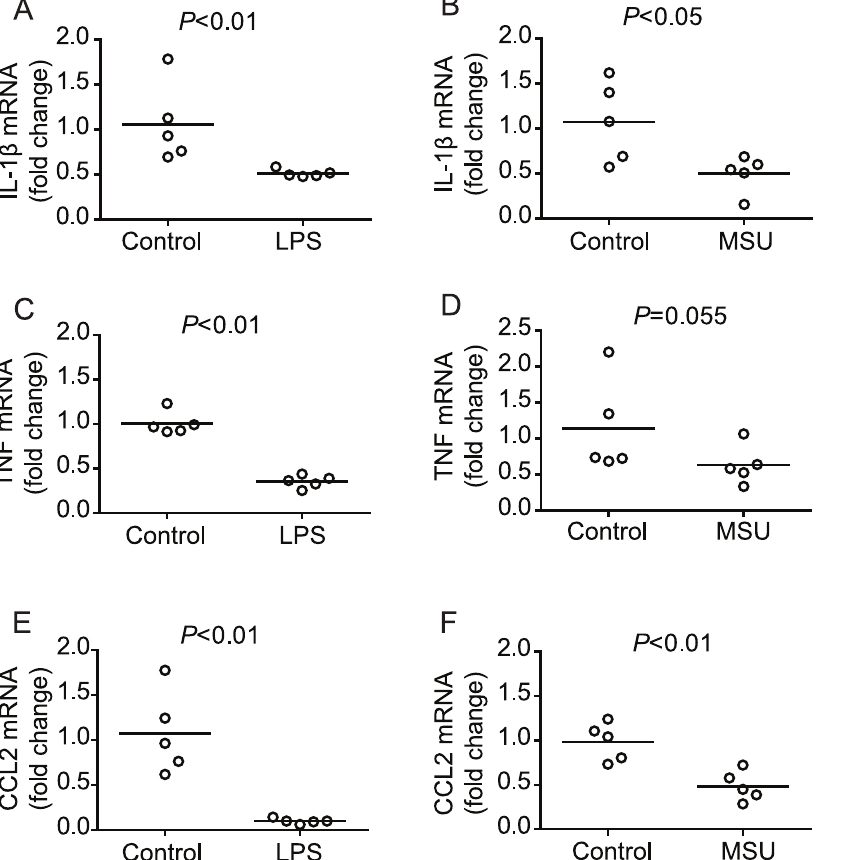
Figure 4. Chronic LPS or MSU administration restores regulation of pro-inflammatory cytokine transcription in infected RAG 2 / 2 mice. Groups of S. mansoni -infected RAG 2 / 2 mice were repeatedly treated throughout pre-patent infection with either LPS (A, C, E) or MSU (B, D, F), as described in Materials and Methods. At 6 weeks p.i., mice were euthanized and spleens removed for analysis of IL-1 b (A and B), TNF (C and D) and CCL2 (E and F) mRNA content by real-time PCR. Horizontal bars represent mean values for each experimental group. P values were calculated using the Mann Whitney test.